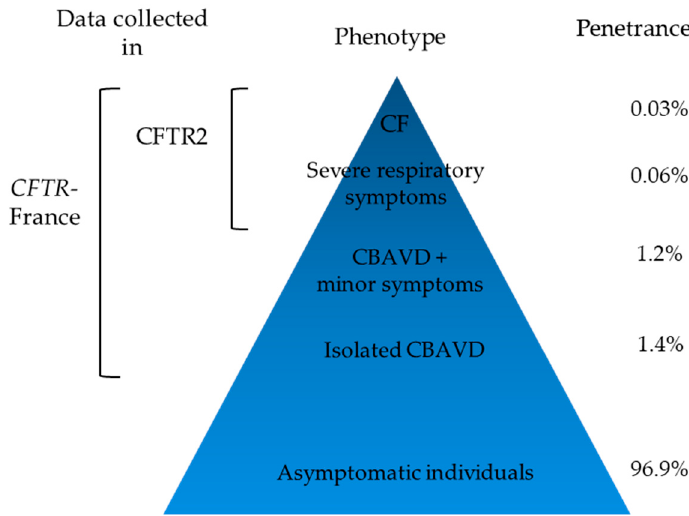
Figure 3. Penetrance of phenotypes in individuals who are compound heterozygous for c.[350G>A;1210-12T[7]];[1521_1523del] (R117H;T7/F508del) from Thauvin et al. [67].